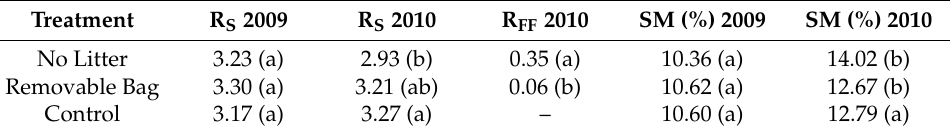
Table 2. Effects of forest floor removal treatments on total soil respiration (R S ), forest floor respiration (R FF ) (calculated after litter treatment in 2010 only), and soil moisture (SM) before (2009) and after (2010) experimental litter removal treatment in red pine stands. Different letters indicate significant